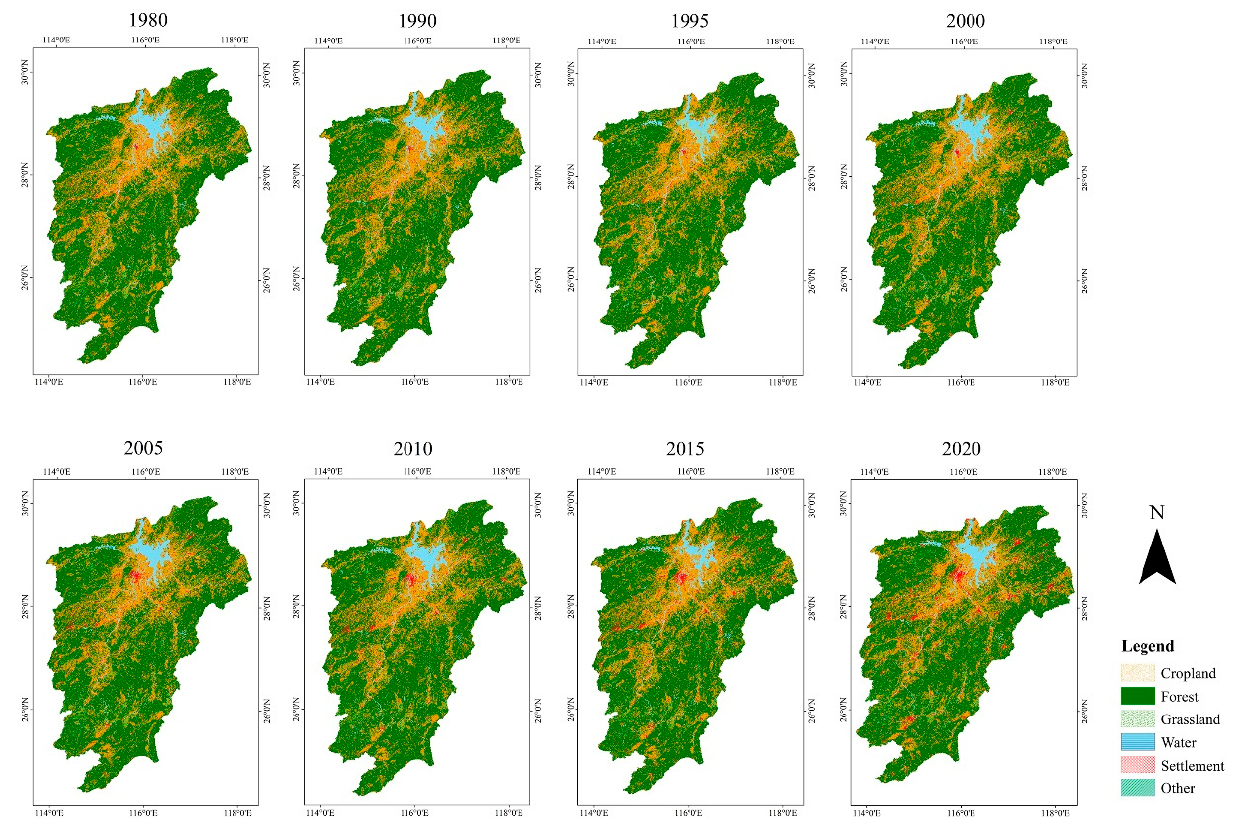
Figure 10. Characteristics of land use in the Poyang Lake basin during 1980–2020.